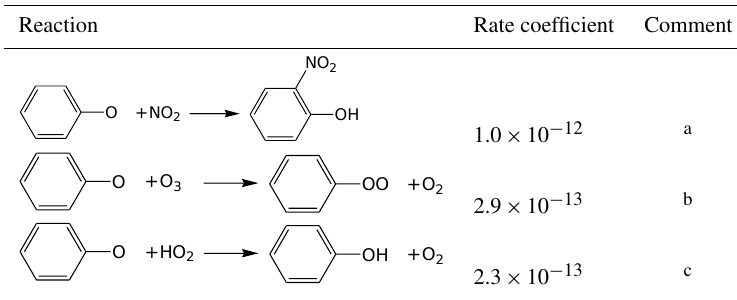
Table 10. Reactions represented for phenoxy and substituted phenoxy radicals, and their assigned rate coefficients (in units cm 3 molecule − 1 s − 1